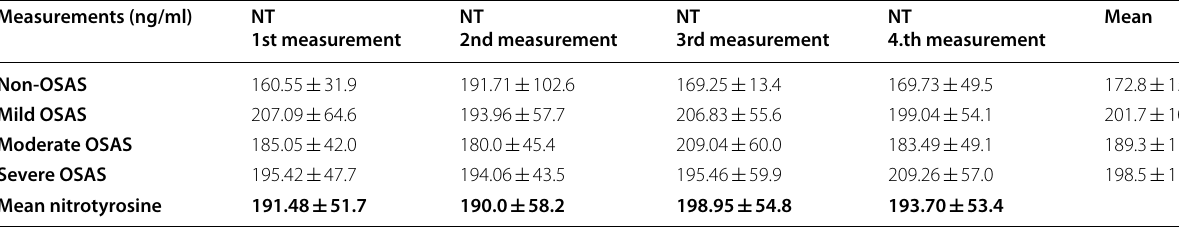
OSAS obstructive sleep apnea syndrome. Group 1: AHI: < 5, group 2: AHI: 5–15, group 3: AHI: 15–30, group 4: AH >: 30. Mean